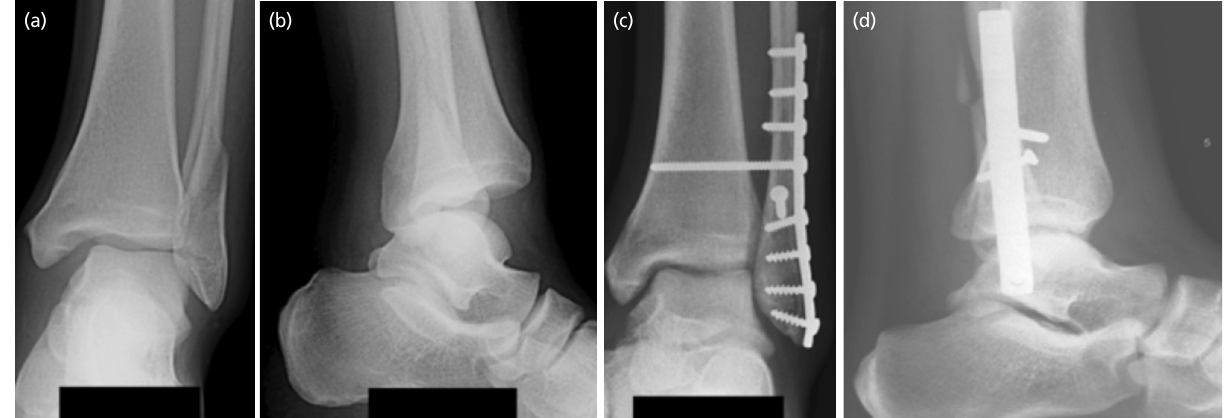
Fig. 5: Patient 3 – (a, b) Pre-operative and (c, d) post-operative. (a) Antero-posterior and (b)